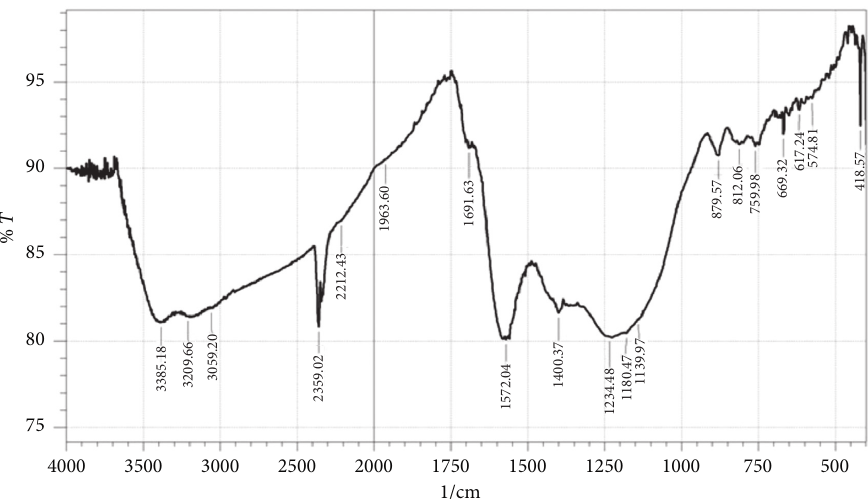
Figure 2: FTIR spectrum of Moringa oleifera seed husk activated carbon.